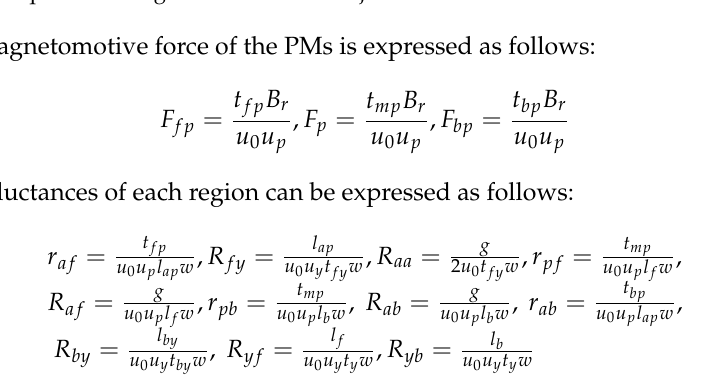
Figure 6. The equivalent magnetic circuit of the ejection unit.